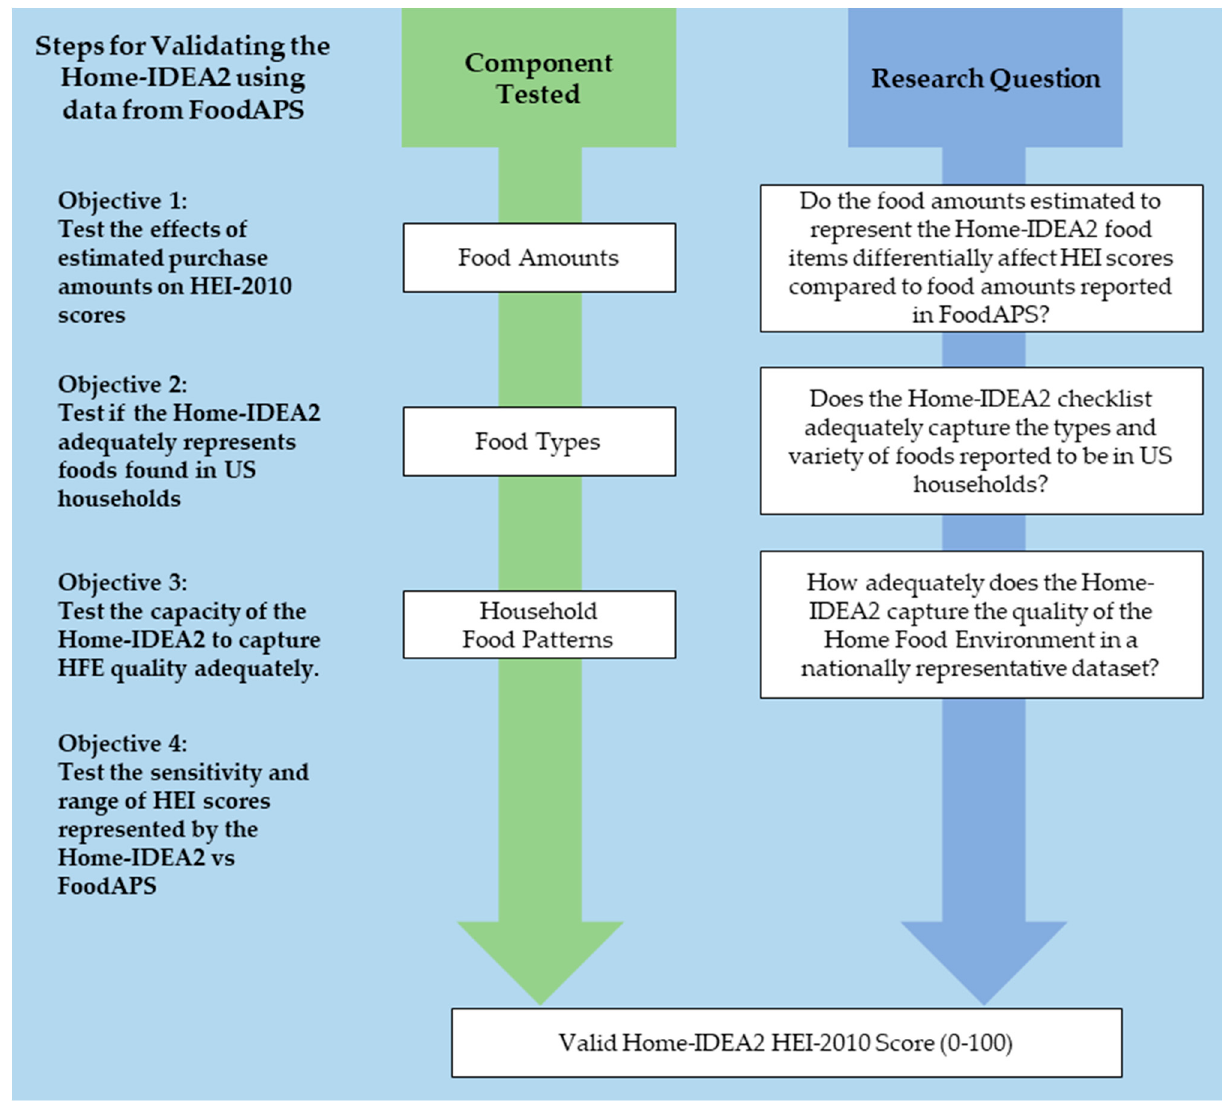
Figure 1. Summary of testing external validity for HEI scores for Home-IDEA2 against HEI scores for FoodAPS, and the validation questions guiding each objective. HEI: Healthy Eating Index. Home-IDEA2: Home Inventory for Describing Eating and Activity, version 2. FoodAPS: National Food Acquisition and Purchase Survey.